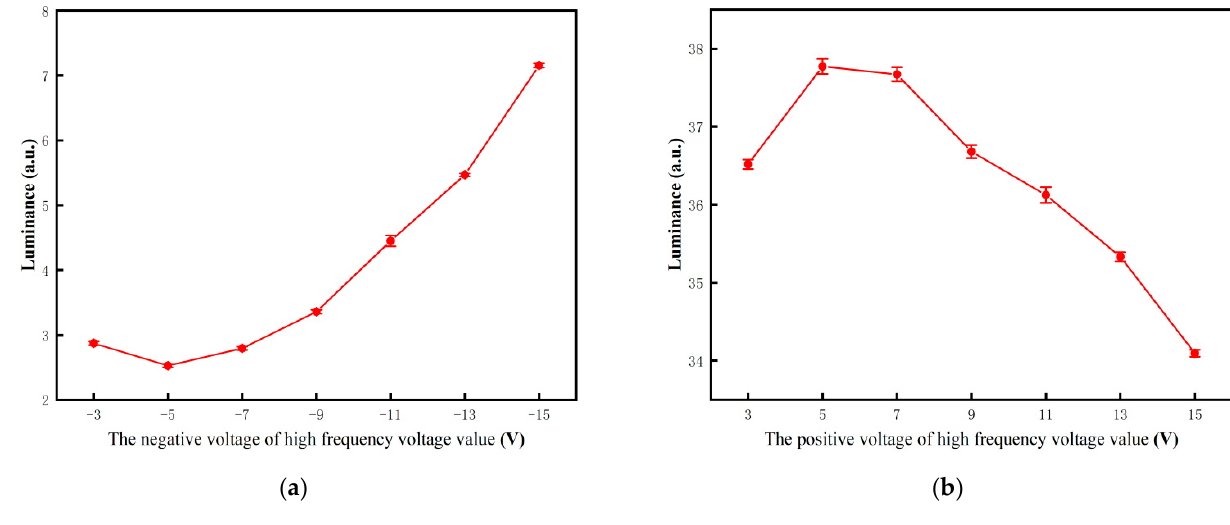
Figure 5. The relationship between luminance and activation voltage. ( a ) The luminance when it was driven by different V A 2 s when V A 1 was set to 15 V. The luminance was decreased with the decrease of V A 2 from − 3 to − 5 V, and it was increased with the decrease of V A 2 from − 5 to − 15 V. The minimum luminance of the three-color EPD was obtained when V A 2 was − 5 V. ( b ) The luminance when it was driven by different V A 1 s when V A 2 was set to − 15 V. The luminance was increased with the increase of V A 1 from 3 to 5 V, and it was decreased with the increase of V A 1 from 5 to 15 V. The maximum luminance of the three-color EPD was obtained when V A 1 was 5